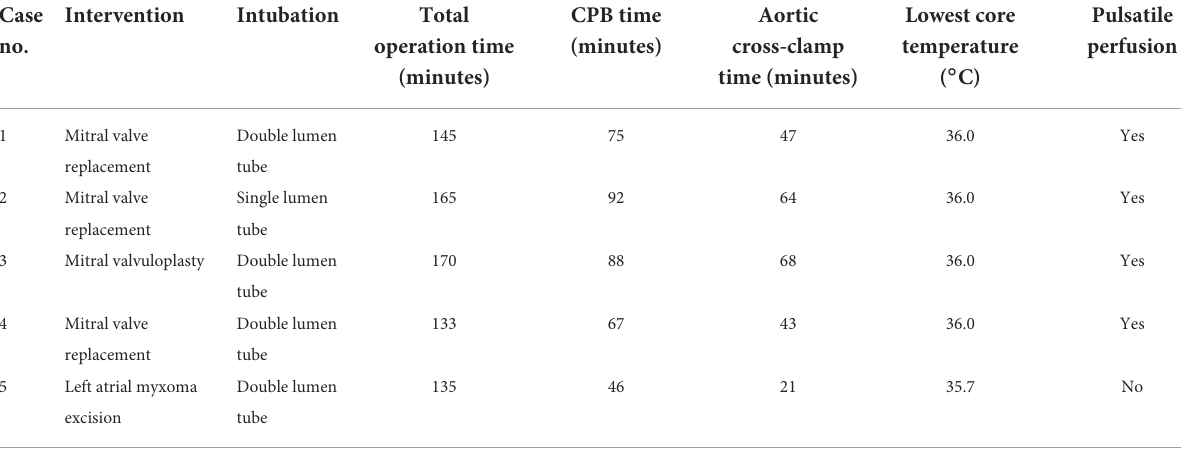
TABLE 2 Intraoperative information of five patients undergoing MICS during pregnancy.